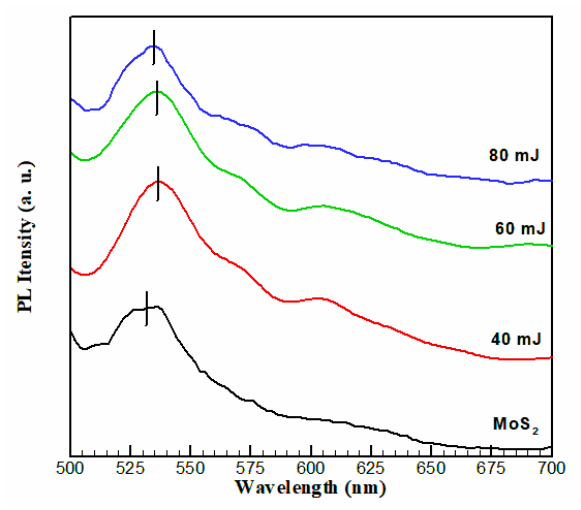
Figure 6. Room temperature photoluminescence spectra of the few-layered MoS 2 under various laser energies from 40 to 80 mJ.